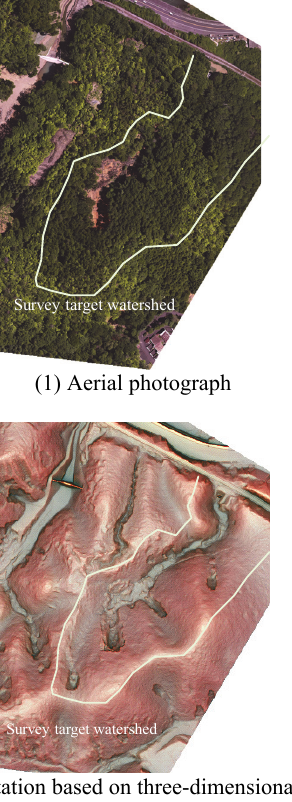
Figure 1. (1) Aerial photograph and (2) topography of the target watershed